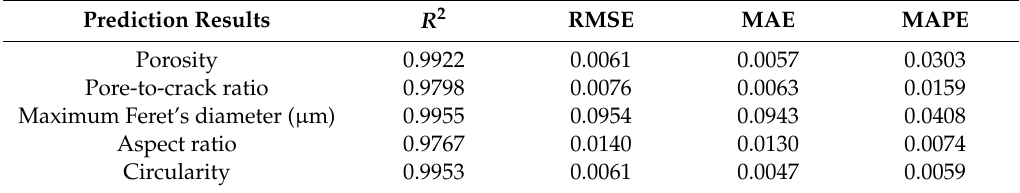
Table6. Thepredictionperformance ofthe 3remainingrandom samplesobtainedby theCS-SVM model. Prediction